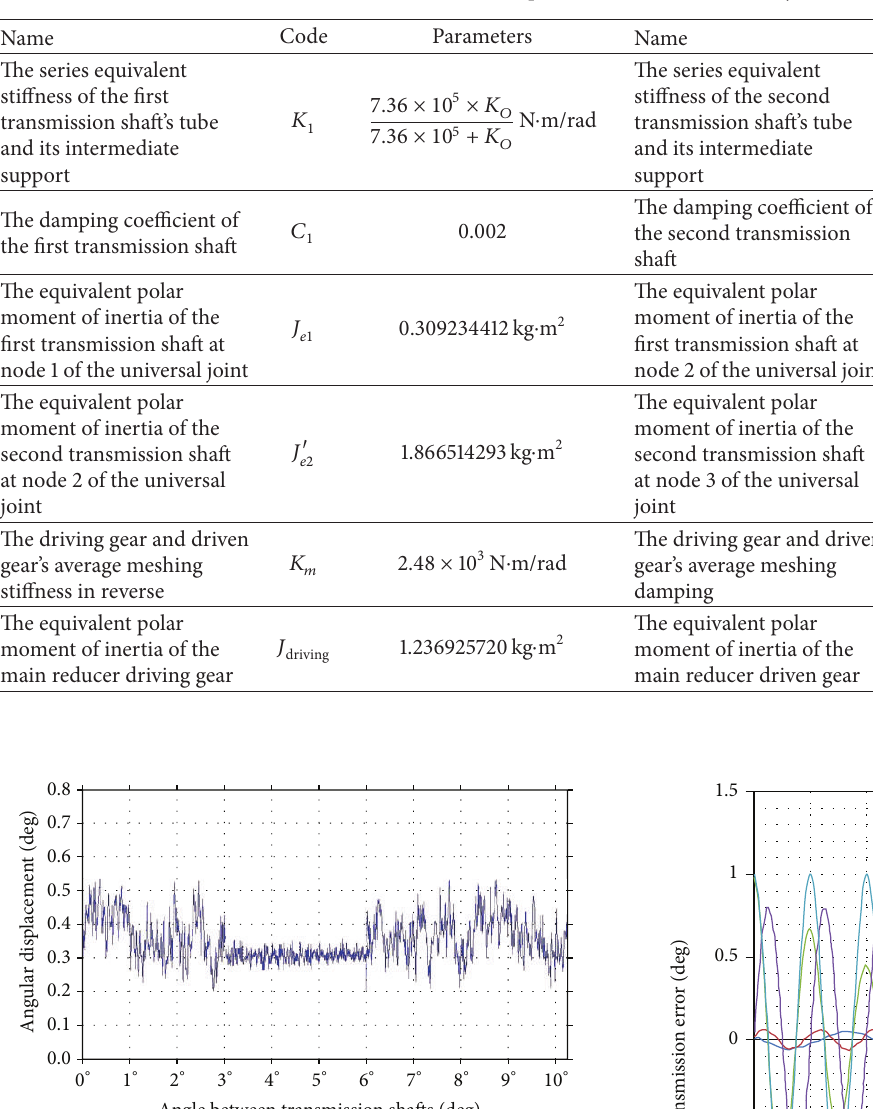
Table 5: Main parameters of transmission system.